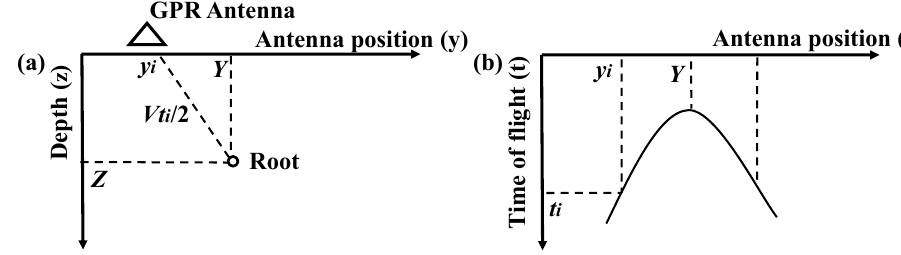
Figure 4. ( a ) The GPR detection of a root; and ( b ) hyperbolic reflection in B-scan. This figure has been modified from that in Giovanni Borgioli